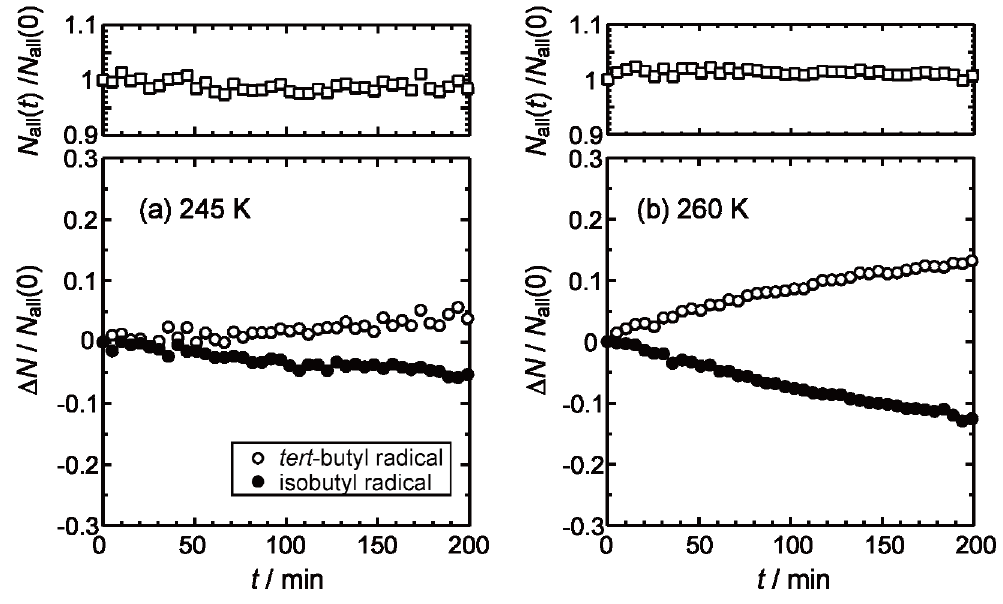
Figure 3. Representative results of isothermal annealing experiments at ( a ) 245 K and ( b ) 260 K in the γ -ray-irradiated isobutane hydrate (D amount of both butyl radicals; Bottom panel: Changing amount of isobutyl (solid circles) and tert -butyl radicals (open circles).